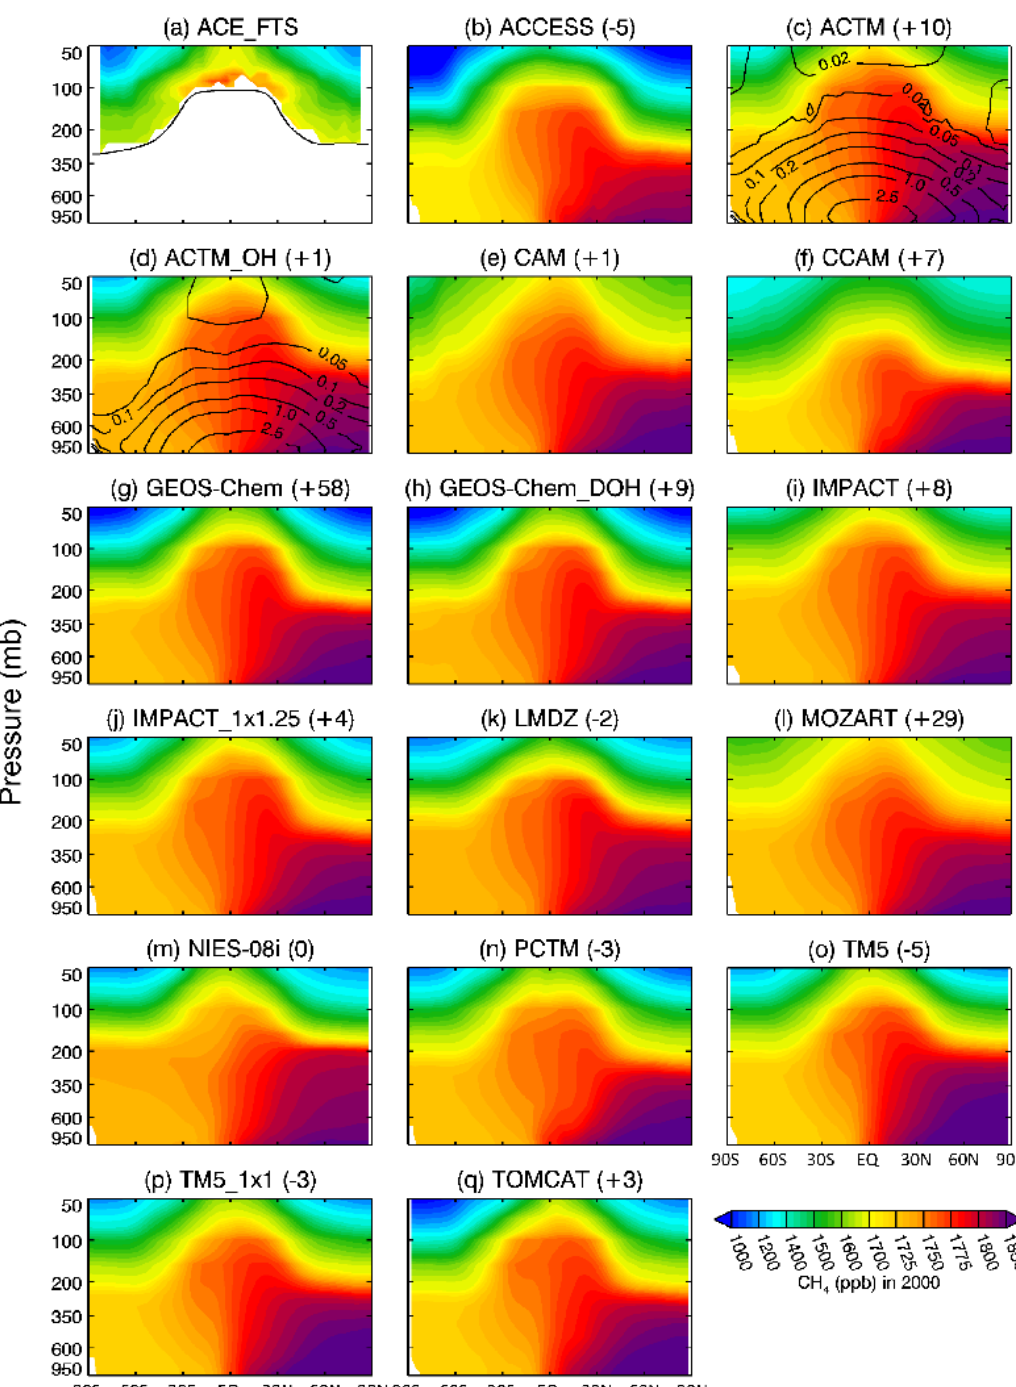
Fig. 3. Annual and zonal mean latitude-pressure (in mb) cross-sections of CH 4 for tropospheric and lower stratospheric altitudes as observed by the ACE-FTS instrument ( a ; climatology) and as simulated by the models in 2000 (b–q) . The black line in (a) shows the climatological tropopause height. The contour lines in ( c and d ) show CH 4 loss rate (units: moleculecm − 3 s − 1 ) as in the ACTM and ACTM OH, respec- tively. An offset is added to the concentrations in each panel (given after the model name in ppb) that adjusts the model fields to a common average value of 1770ppb between 950mb and 500mb. Detailed model-to-model comparisons for 222 Rn, SF 6 , CH 4 and CH 3 CCl 3 for two seasons and over two longitudes are available in the Supplement (Figs.